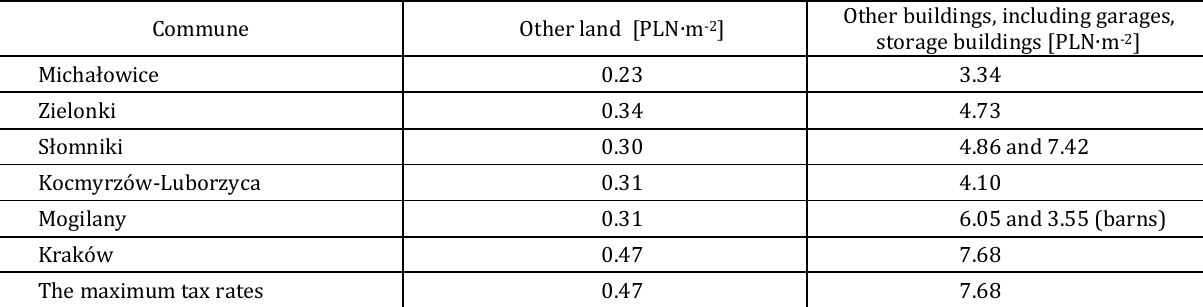
Table 1. Tax rates in Krakow and selected communes of the Krakow district ( powiat ) in 2016 (source: Own work based on information on Municipalities’ websites) Other buildings, including Commune Other land [PLN∙m -2 ]